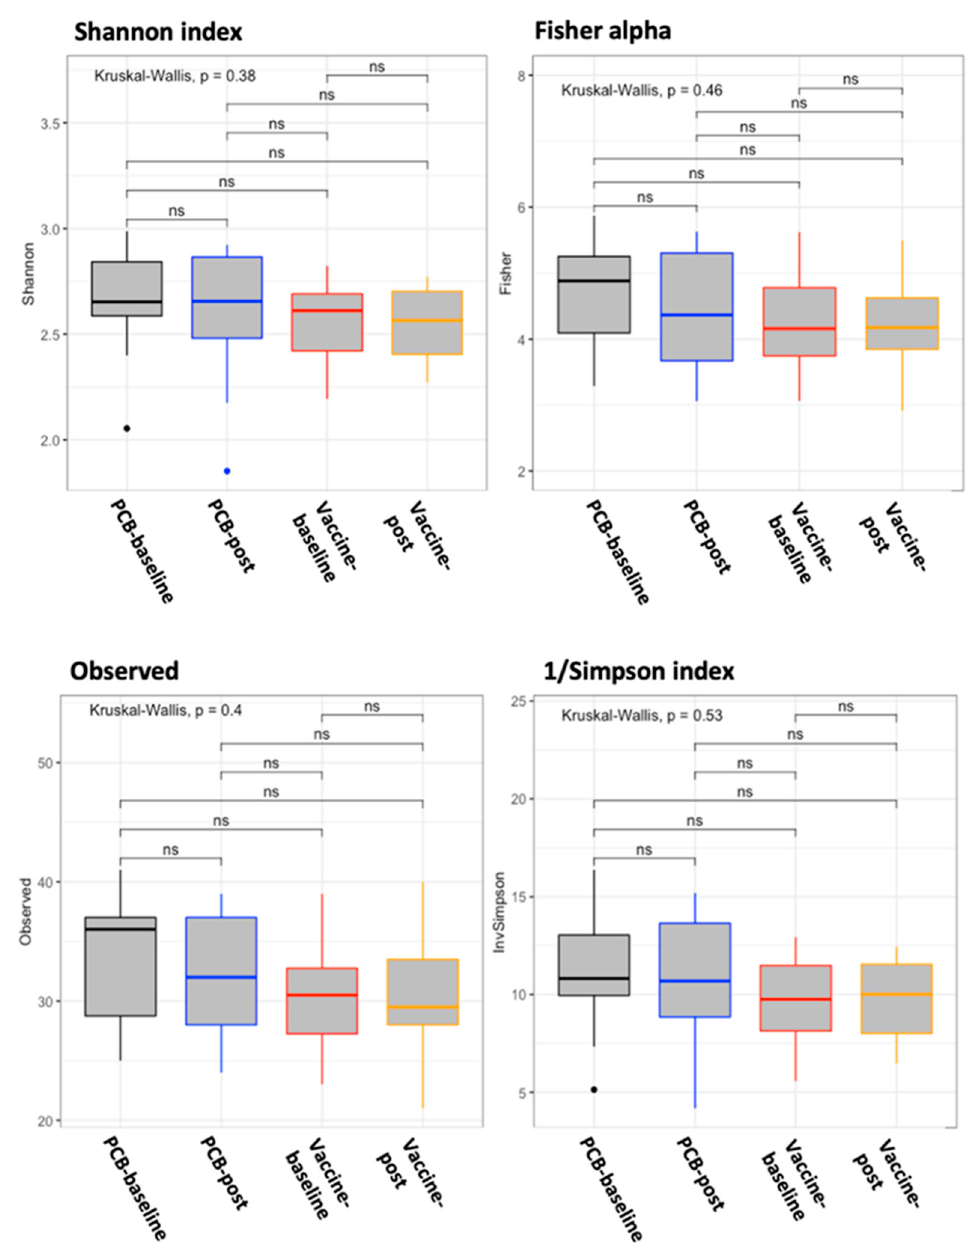
Figure 2. Alpha diversity by randomization group at different time points. Placebo (PCB) baseline (week 0) samples were represented in the black boxes, PCB post-vaccination in the blue boxes, vaccine baseline samples in the red boxes, and post-vaccination (post, week 5) samples in the orange boxes. Left-top: Shannon index, right-top: Fisher alpha index, left-bottom: number of observed OTUs, and right-bottom: inverse Simpson (1/Simpson) index. Box plots represent the median (black horizontal line), 25th, and 75th quartiles (edge of boxes) and upper and lower extremes (whiskers). For every parameter, the global Kruskal–Wallis p -value and the p -values for every comparison between the randomized groups at different time points are presented. p -Values code: p < 0.005: ***, p < 0.01: **, p ≤ 0.05: *, and p > 0.05: ns.